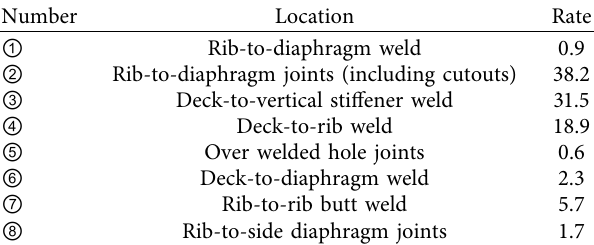
Figure 16: Typical fatigue vulnerable locations of OSD. Table 5: Typical fatigue vulnerable location of OSD (unit: %).